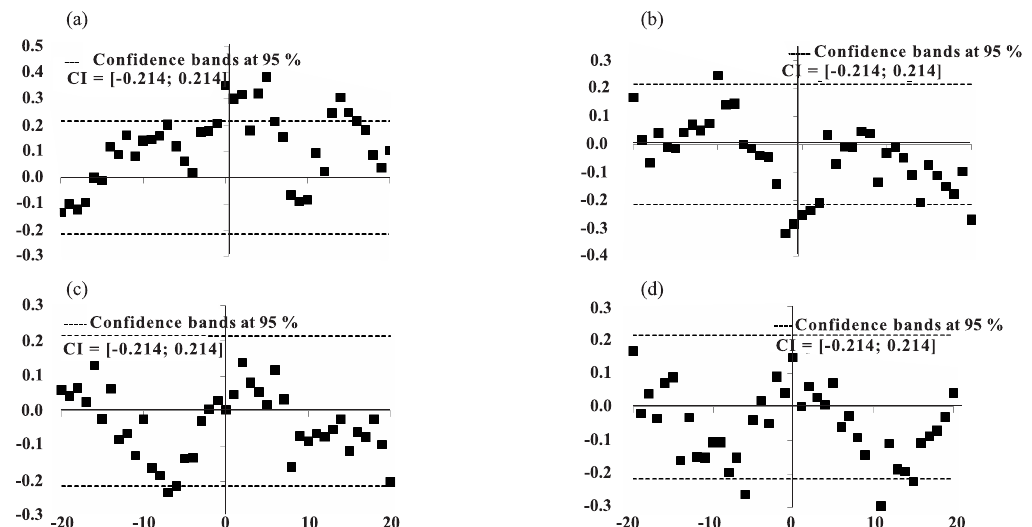
Figure 3. Cross correlograph between: (a) soybean yield and soil penetration resistance in the 0–0.10 m layer; (b) soybean yield and soil penetration resistance in the 0.10–0.20 m layer; (c) soybean yield and soil bulk density in the 0–0.10 m layer; and d) soybean yield and soil bulk density in the 0.10–0.20 m